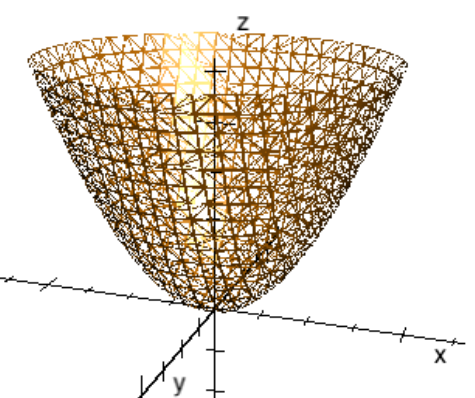
Figure 13. Outline of the model behavior in three dimensions plotted from Equation (14).